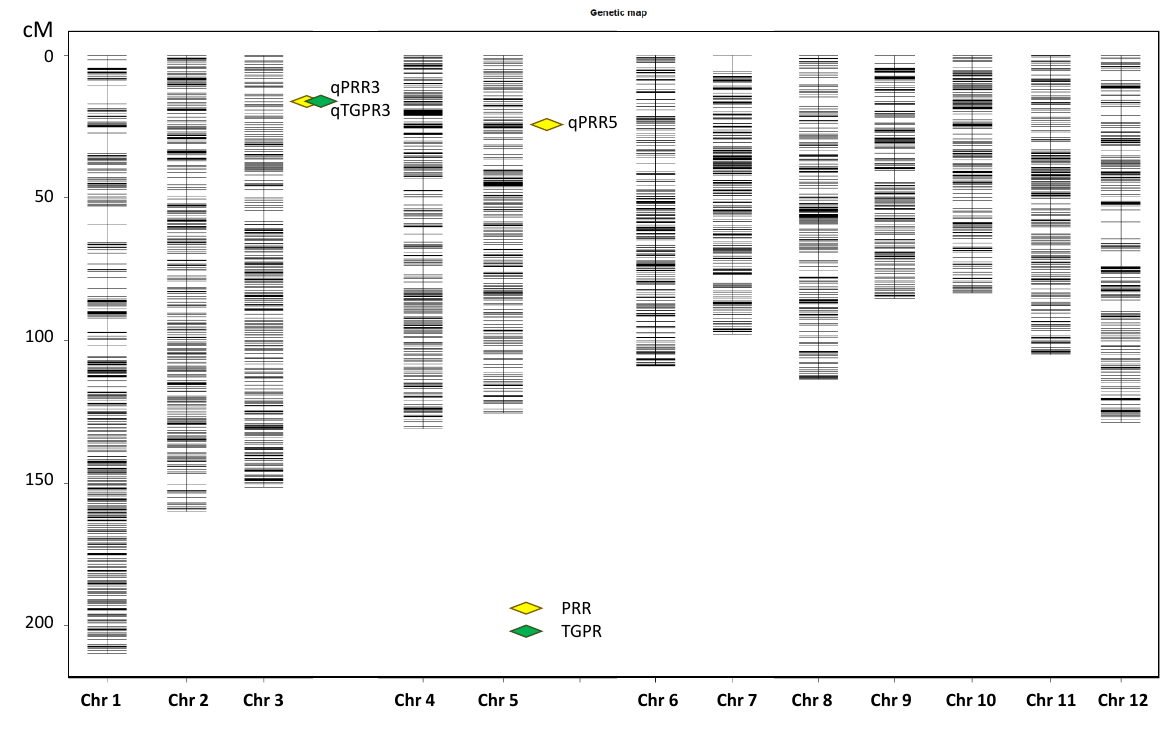
Figure 2. Statistical analysis of PRR and TGPR. ( A ) Frequency distribution diagram of PRR, with arrows indicating the level of the parents 93-11 and Nip. ( B ) Frequency distribution diagram of TGPR in the population, with arrows representing the level of the parents 93-11 and Nip. ( C ) Cor- relation coefficients between PRR and TGPR.